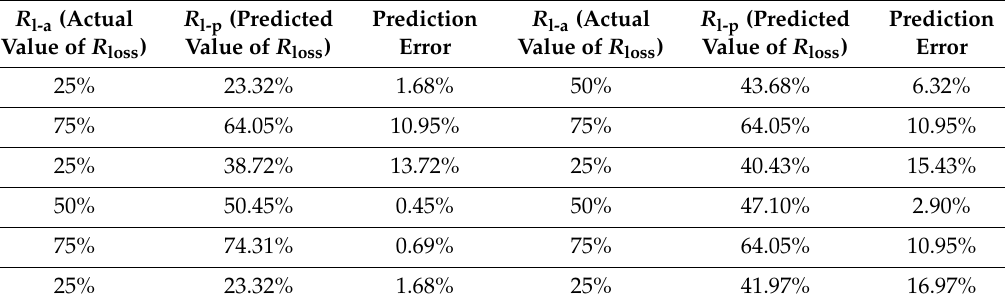
Table 11. Comparison of monitored and actual values(using the univariate V m